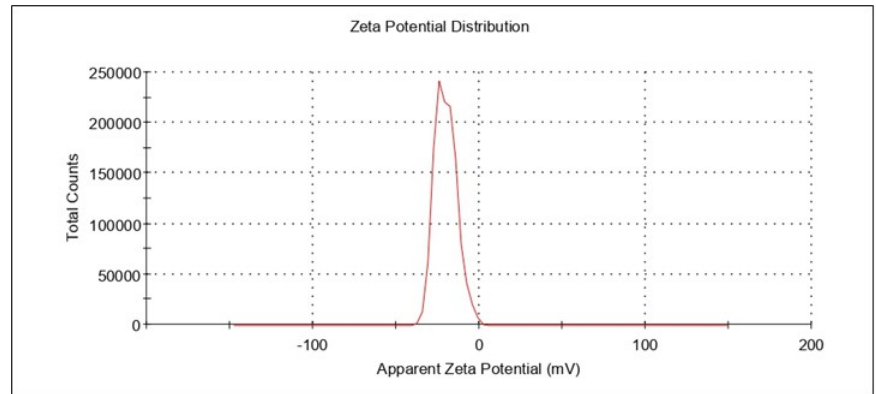
Figure 6. Representative plots for zeta potential.